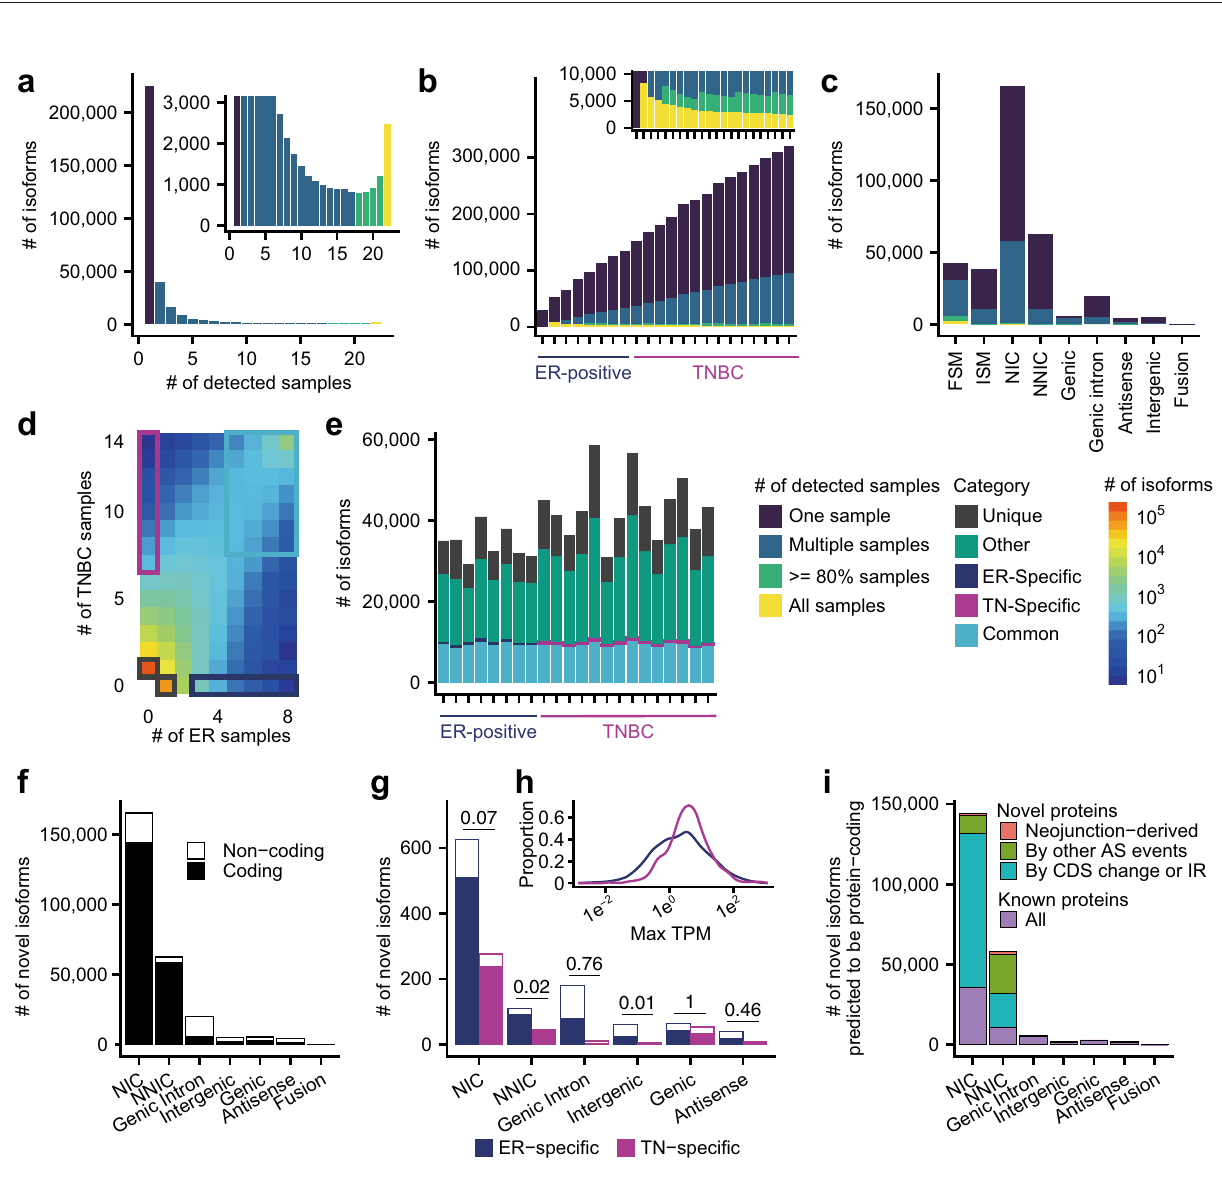
Fig. 2 Isoform distribution detected by MuSTA. a A histogram of the number of isoforms as a function of the number of samples that generated the isoforms. b The number of detected isoforms when incrementing sample numbers one by one and performing MuSTA. c The number of isoforms for each SQANTI category, which represents the similarity to reference transcripts. FSM full-splice match, ISM incomplete-splice match, NIC novel in catalog, NNIC novel not in catalog. d A heatmap representing the distribution of the number of isoforms from ER-positive and triple-negative subtypes. The groups of isoforms indicated by light blue, blue, purple, and black rectangles were de fi ned as common, ER-speci fi c, TN-speci fi c, and unique, respectively. e The distribution of isoforms according to their categories de fi ned in d . f The number of isoforms restricted to unannotated SQANTI categories. Colored bars represent isoforms predicted to have protein-coding potential. g Bar plot representing the number of subtype-speci fi c isoforms. P -values for the difference in the ratio of protein-coding isoforms are shown (two-sided Fisher ’ s exact test, Benjamini – Hochberg corrected). h The distribution of maximum transcript per million (TPM) for subtype-speci fi c isoforms. The x axis is shown on a logarithmic scale. i The origins of novel protein sequences predicted to be transcribed from unannotated transcripts. AS alternative splicing, CDS coding sequence, IR intron